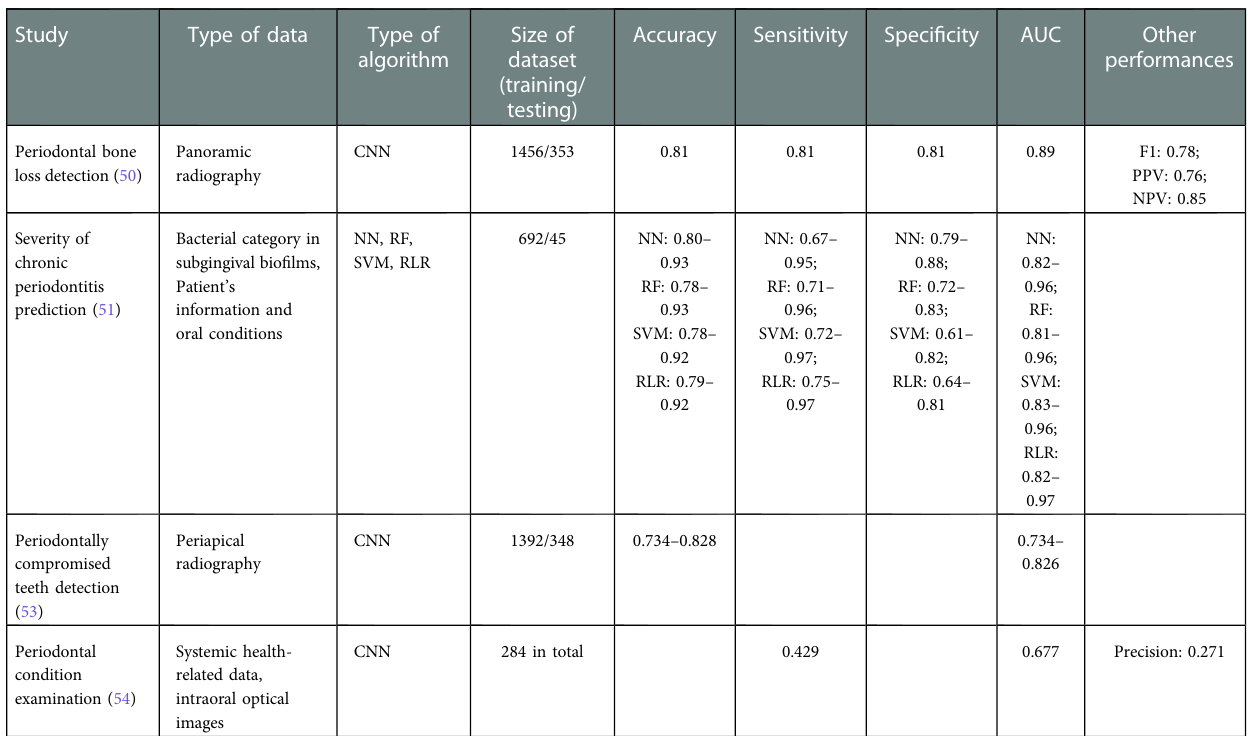
TABLE 3 Examples of AI applications in